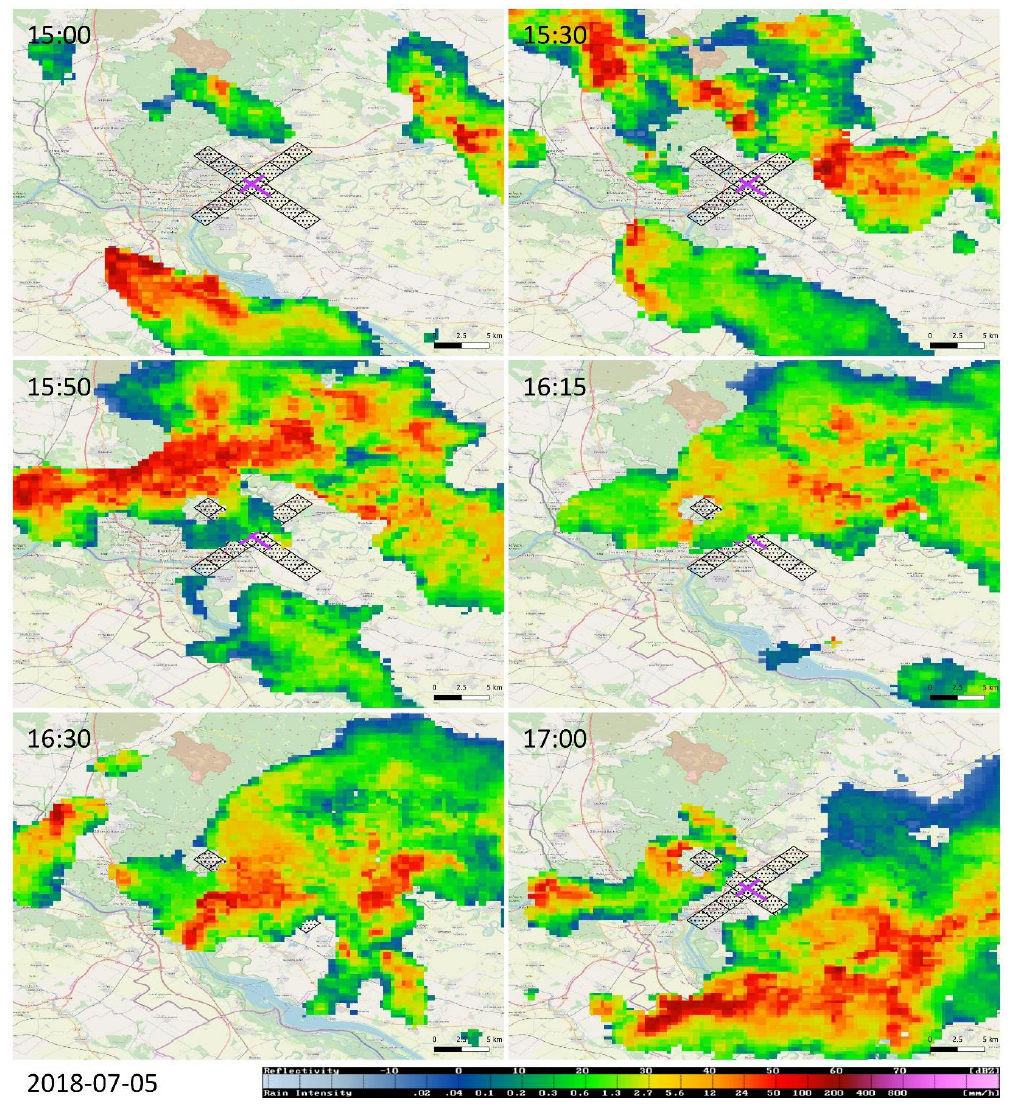
Figure 9. The same weather event as in Figure 8, but seen by the radar at Malý Javorník and displayed in terms of the CAPPI 1.5 km product. The Bratislava Airport is highlighted by the purple cross, while the corresponding ARENA is indicated by the black-dotted rectangles.